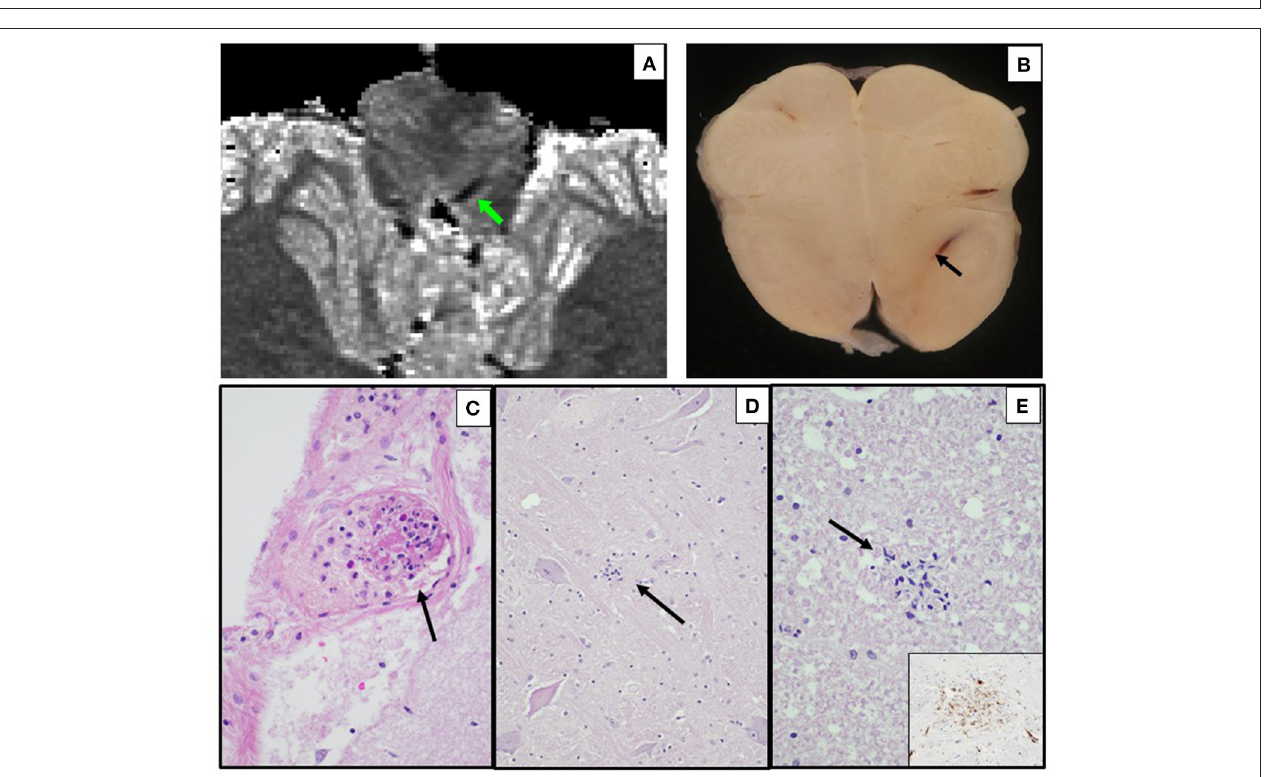
FIGURE 4 | Ex vivo MRI and autopsy neuropathology in Case 6. (A) Ex-vivo axial T * 2 parametric map derived from multi-echo gradient-echo MRI, showing a linear region of susceptibility-induced T * 2 shortening in the medulla. (B) Corresponding axial section of the medulla, with same prominent parenchymal vein (arrow). (C) Leptomeningeal venule containing fibrin and inflammatory cells (early non-occlusive thrombus) (arrow) (H&E, 400x). (D) Medulla with microglial nodule (arrow) (H&E, 200x). (E) Cervical spinal lateral funiculus microglial nodule (H&E, 400x; inset, CD68 immunostain, 400x).